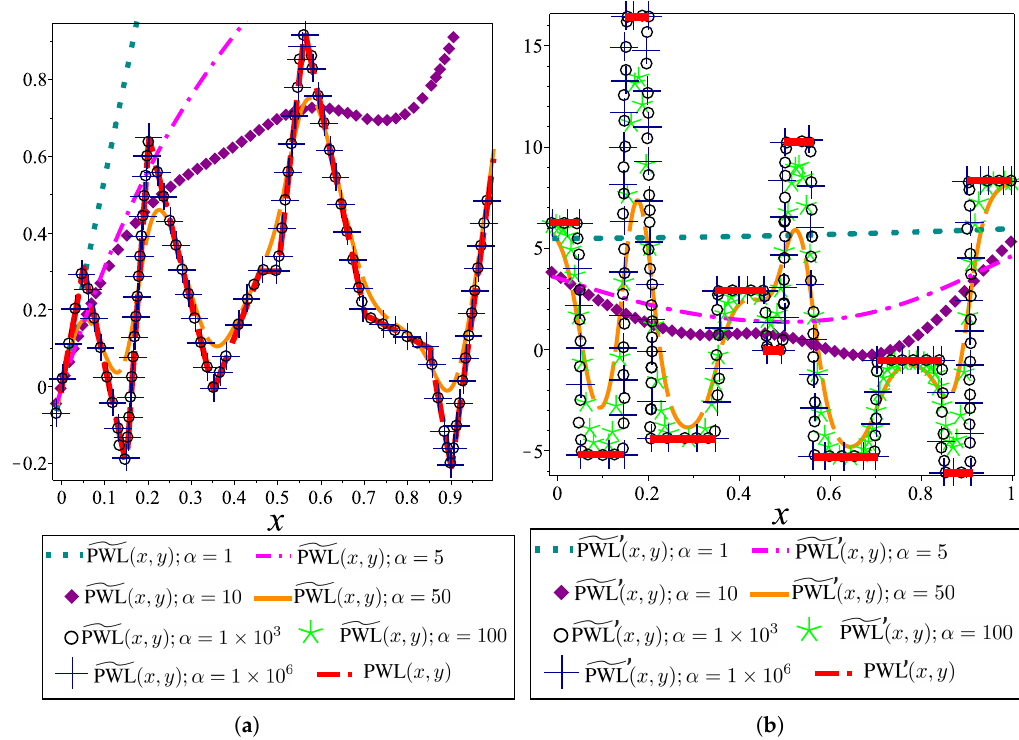
Figure 8. Smooth and differentiable piecewise linear function ( (cid:103) PWL). ( a ) (cid:103) PWL function generated with approximation of absolute value function. ( b ) First derivation of smooth (cid:103) PWL